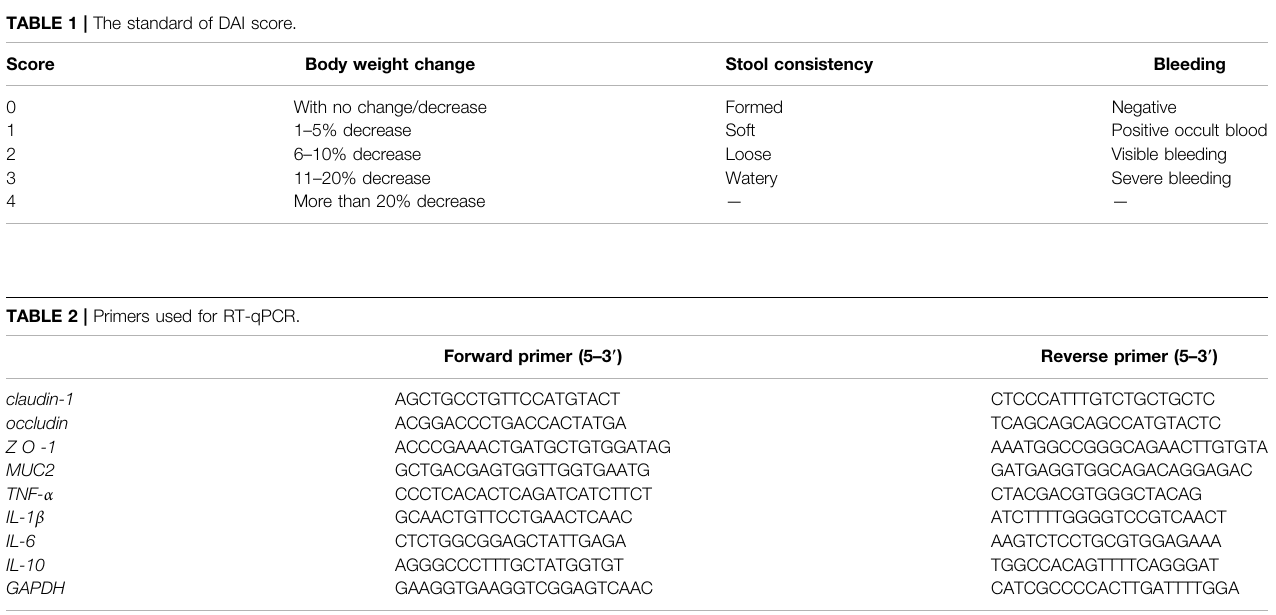
and 6 μ l of nuclease-free water. Primer sequences were listed in Table 2 . Real time PCR conditions were as follows: 5 min denaturation at 98 ° C, followed by 33 cycles at 95 ° C at 30 s, 60 ° C for 30 s, and then 72 ° C for 1 min. Data were analyzed using the CFX Manager software (Bio-Rad, California, United States). The data were normalized against GAPDH and expressed as fold change over mock (2 − ΔΔ Ct ). Each sample was treated in triplicate to ensure statistical analysis signi fi cance.